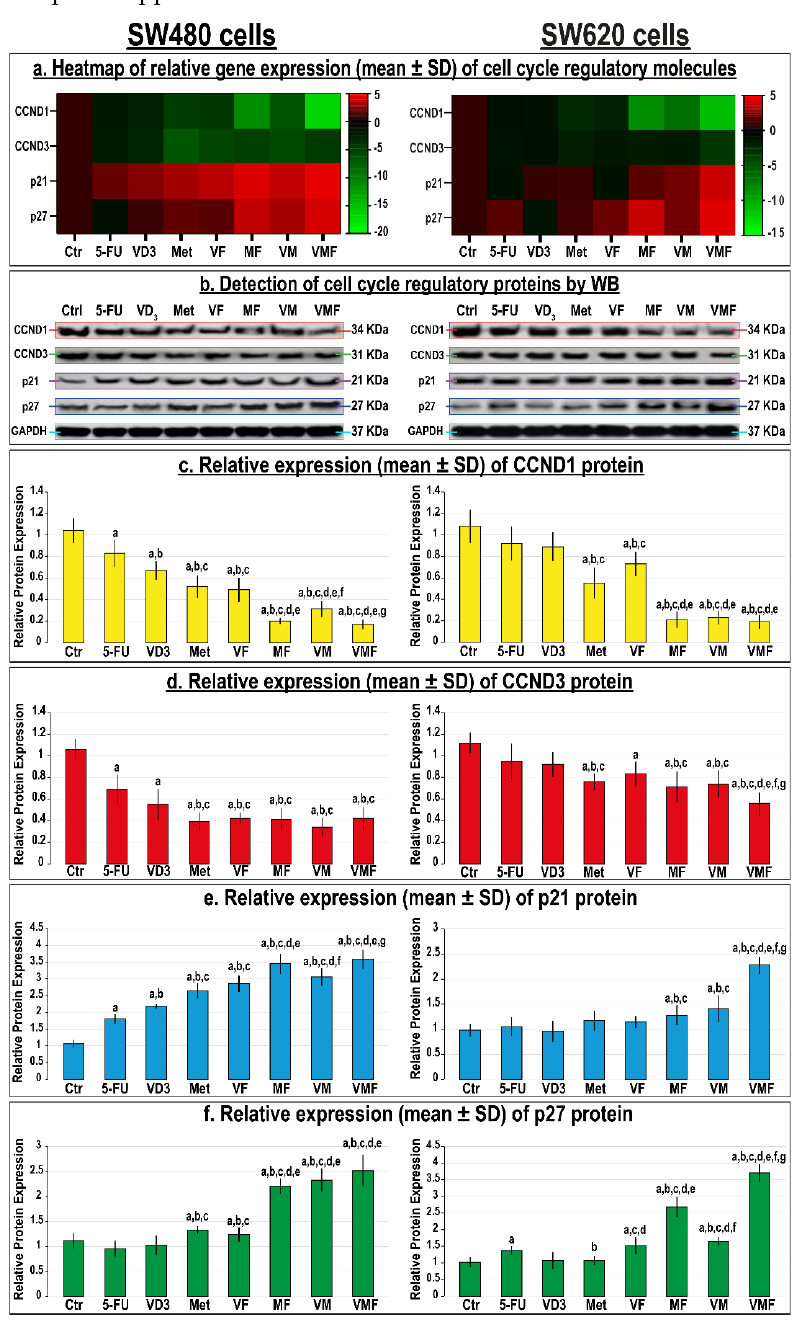
Figure 4. ( a ) Heatmap showing relative mRNA expression (mean ± SD) of CCND1, CCND3, p21, and p27 genes alongside ( b ) detection of their proteins by Western blot and ( c – f ) their relative protein expression (mean ± SD), following treatments with 5-fluorouracil, calcitriol, and/or metformin single (5-FU, VD 3 , and Met), dual (VF, MF, and VM), and triple (VMF) therapies for 12 h in the SW480 and SW620 colon cancer cell lines (n = 3/group; data were analysed by ANOVA followed by Games–Howell post hoc tests and are shown as the mean ± SD; a = p < 0.05 compared with control untreated cells; b = p < 0.05 compared with 5-FU monotherapy; c = p < 0.05 compared with VD 3 monotherapy; d = p < 0.05 compared with Met monotherapy; e = p < 0.05 compared with VF dual therapy; f = p < 0.05 compared with MF dual therapy; and g = p < 0.05 compared with VM dual